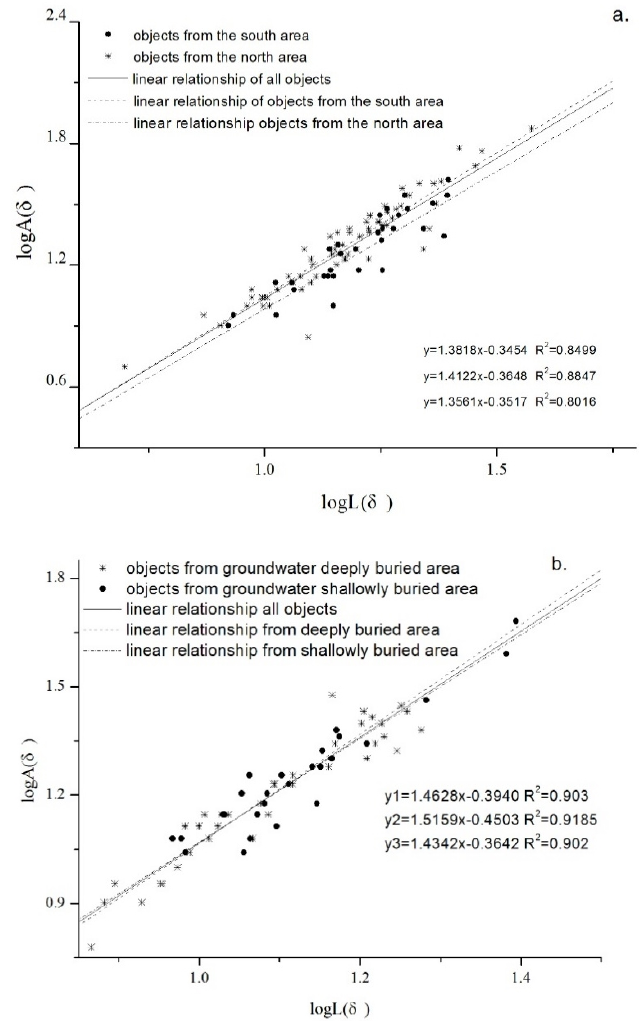
Figure 11. Fractal relationship between area and circumference of polygon connecting the Karst peaks and saddle zones around Karst depressions (shown in Figure 5(a-2,b-2)). ( a ) Pingguo System; ( b ) Dongfeng System.